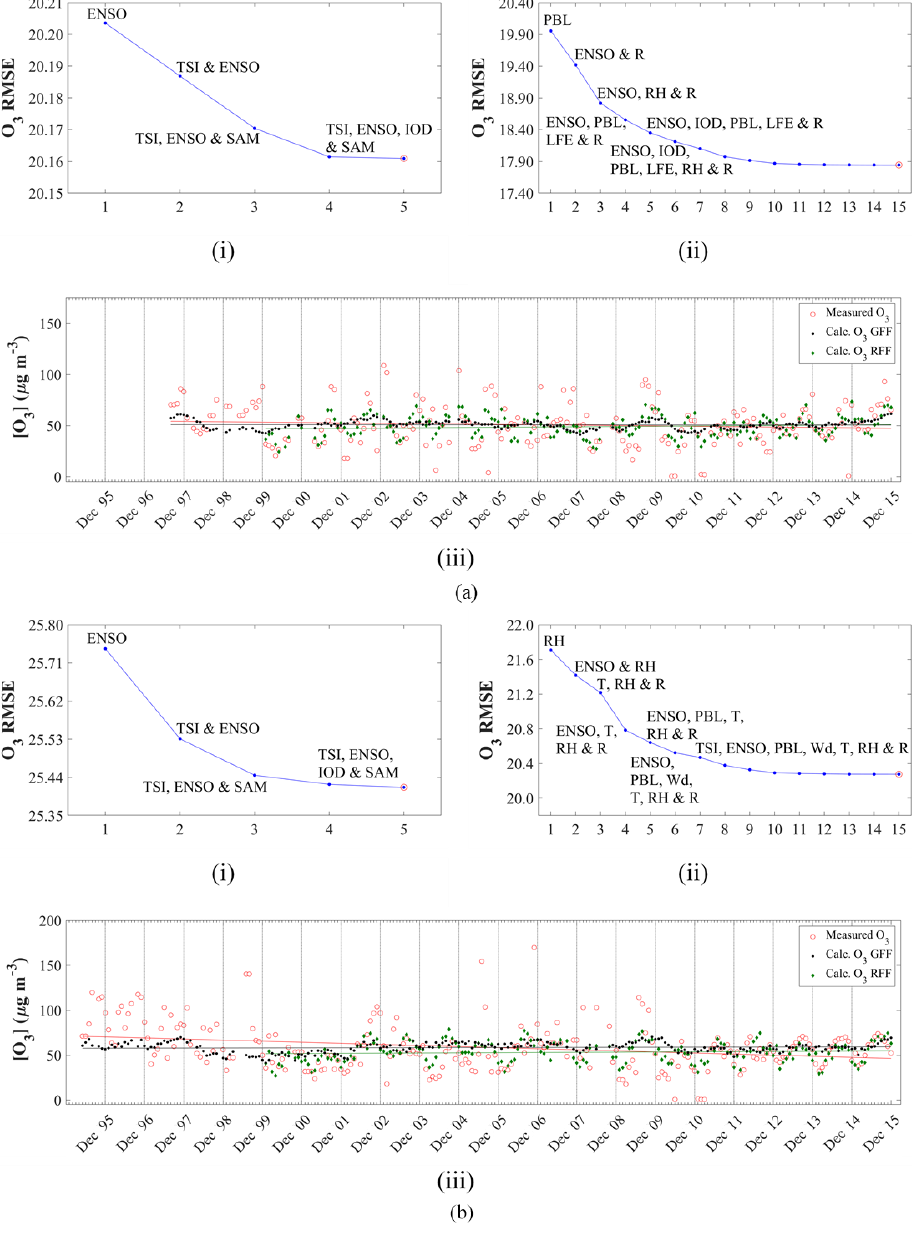
were 52.56 µg m − 3 , and average O 3 concentrations from 2007 to 2015 were 49.10 µg m − 3 ) and − 9 . 15 µg m − 3 per decade (average O 3 concentrations from 1995 to 2004 were 63.16 µg m − 3 , and average O 3 concentrations from 2005 to 2014 were 53.01 µg m − 3 ) were calculated for AF and LT, re- spectively, for the 2 decades. Similar to SO 2 and NO 2 , the slopes of the linear regression trend lines for the measured and modelled O 3 concentrations when local, regional and global factors are included are exactly the same at AF, LT